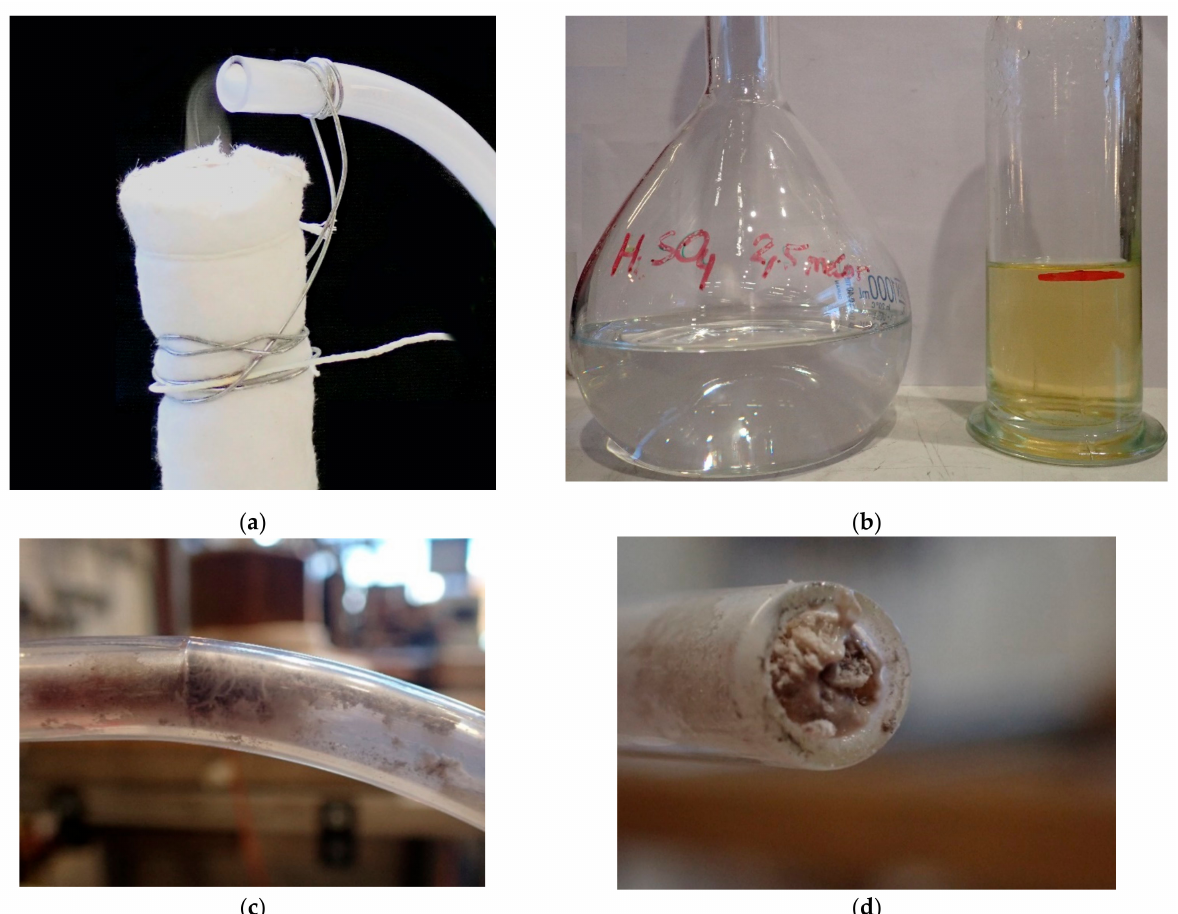
Figure 7. Images related to the gas phase. ( a ) Visible flue gas leaving the InduMelt reactor in the NMC532 experiment. ( b ) Gas scrubbing medium (H 2 SO 4 ) before and after the experiment. ( c , d ) Deposits and clogging inside the gas pipe to the gas scrubber.